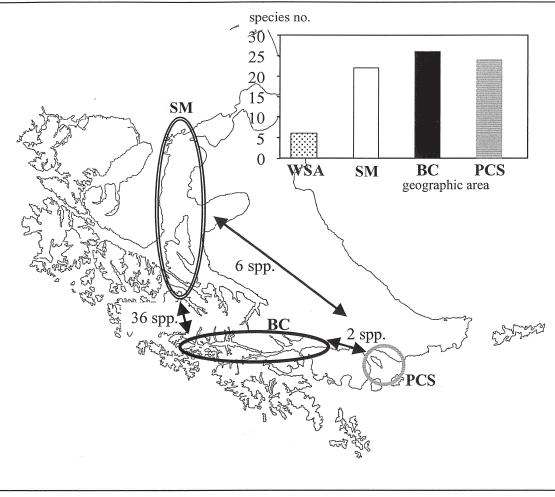
F IG . 5. – Numbers of harpacticoid species in common between the respective geographic areas (arrows with corresponding species (spp.) numbers). The graphic illustration shows the numbers of exclusive harpacticoid species reported from the respective geo- graphical areas: WSA = Whole Study Area, SM = Straits of Magel- lan, BC = Beagle Channel, PCS = Patagonian Continental Slope.